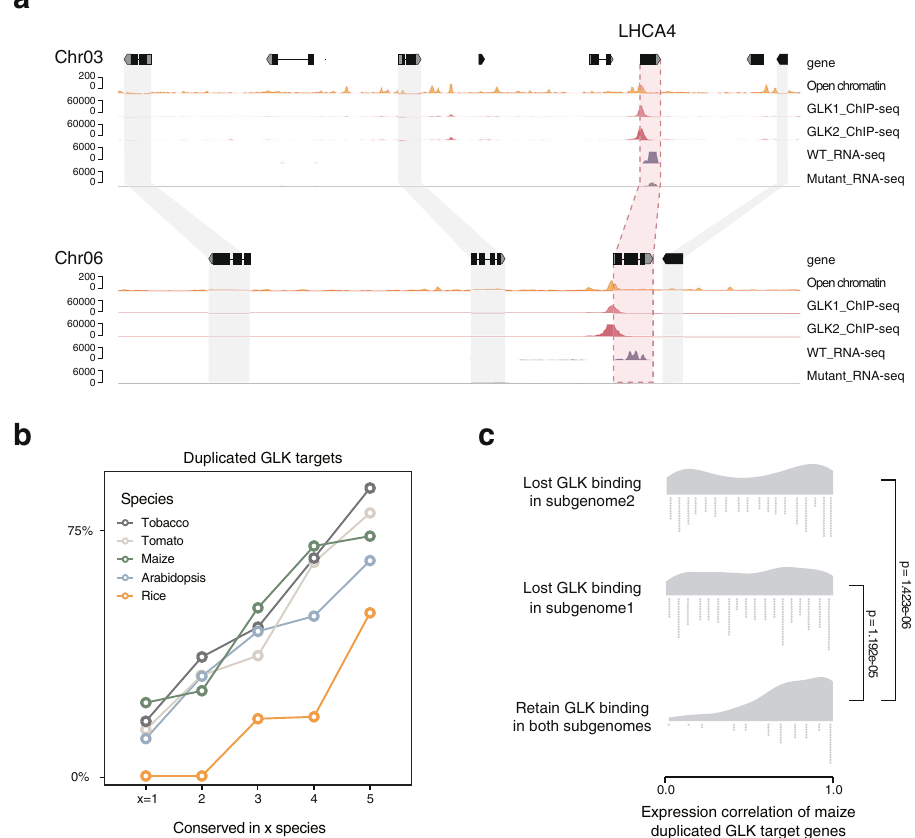
Fig.8|DuplicatedGLKChIP-seqtargetgenes.a Genomebrowsertracksshowing part of the synteny blocks containing two tomato LHCA4 genes. The open chro- matin,GLKChIP-seqandRNA-seqtracksareshown. b Thepercentageofduplicated GLKChIP-seqtargetgenesineachconservationgroup. c Pearsoncorrelationofthe